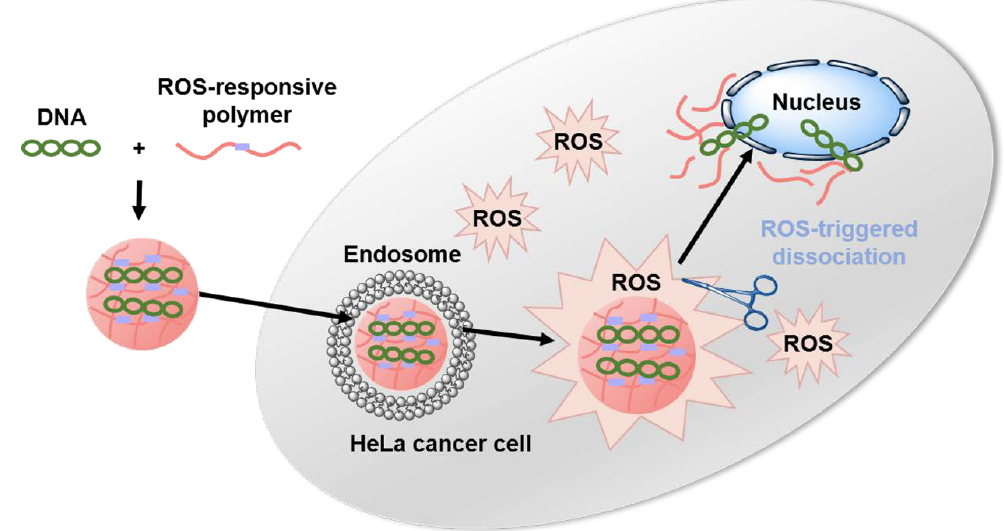
Scheme 1. Illustration of intracellular delivery of plasmid DNA to the nucleus of HeLa cancer cell using ROS-responsive polymer based LWM PEI and thioacetal-linker units.